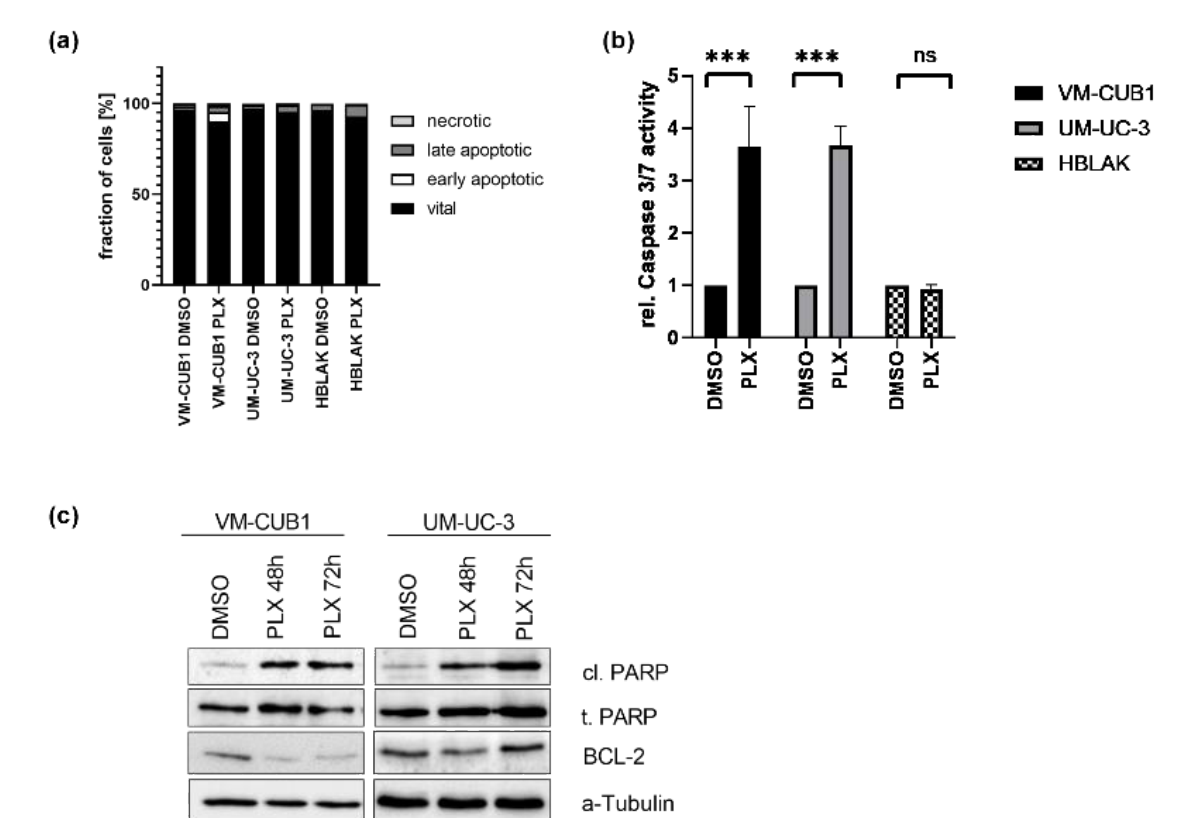
Figure 2. Induction of cell death in UCC after treatment with BETi PLX51107. ( a ) Induction of cell death was measured by annexin V/PI staining and flow cytometry 72 h after treatment with cell line-specific IC 50 doses of PLX or DMSO. Percentages of viable, early apoptotic, late apoptotic, and necrotic cells are displayed in bar graphs in different shades of gray as indicated. ( b ) Likewise, the activity of caspase 3 and 7 was measured in the same samples used for flow cytometry by luminometric caspase assay. In parallel, the samples were used for a luminometric proliferation assay to normalize caspase activity to cell numbers (rel. caspase activity). Further normalization to respective DMSO controls (set as 1) was applied. *** denotes p < 0.001. ns denotes not significant differeneces. ( c ) PARP cleavage (cl. PARP) was determined by western blot analysis after treatment for 48 h and 72 h with PLX. Total PARP protein (t. PARP) was detected as a loading control. Anti-apoptotic protein BCL2 was detected, while α -Tubulin served as a loading control.